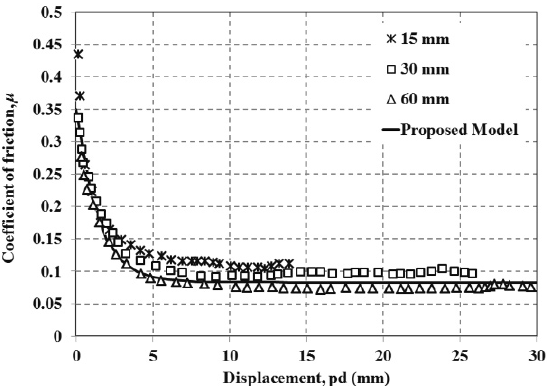
Figure 5. Coefficient of friction versus pullout displacement curves for smooth fiber and high strength SCC.